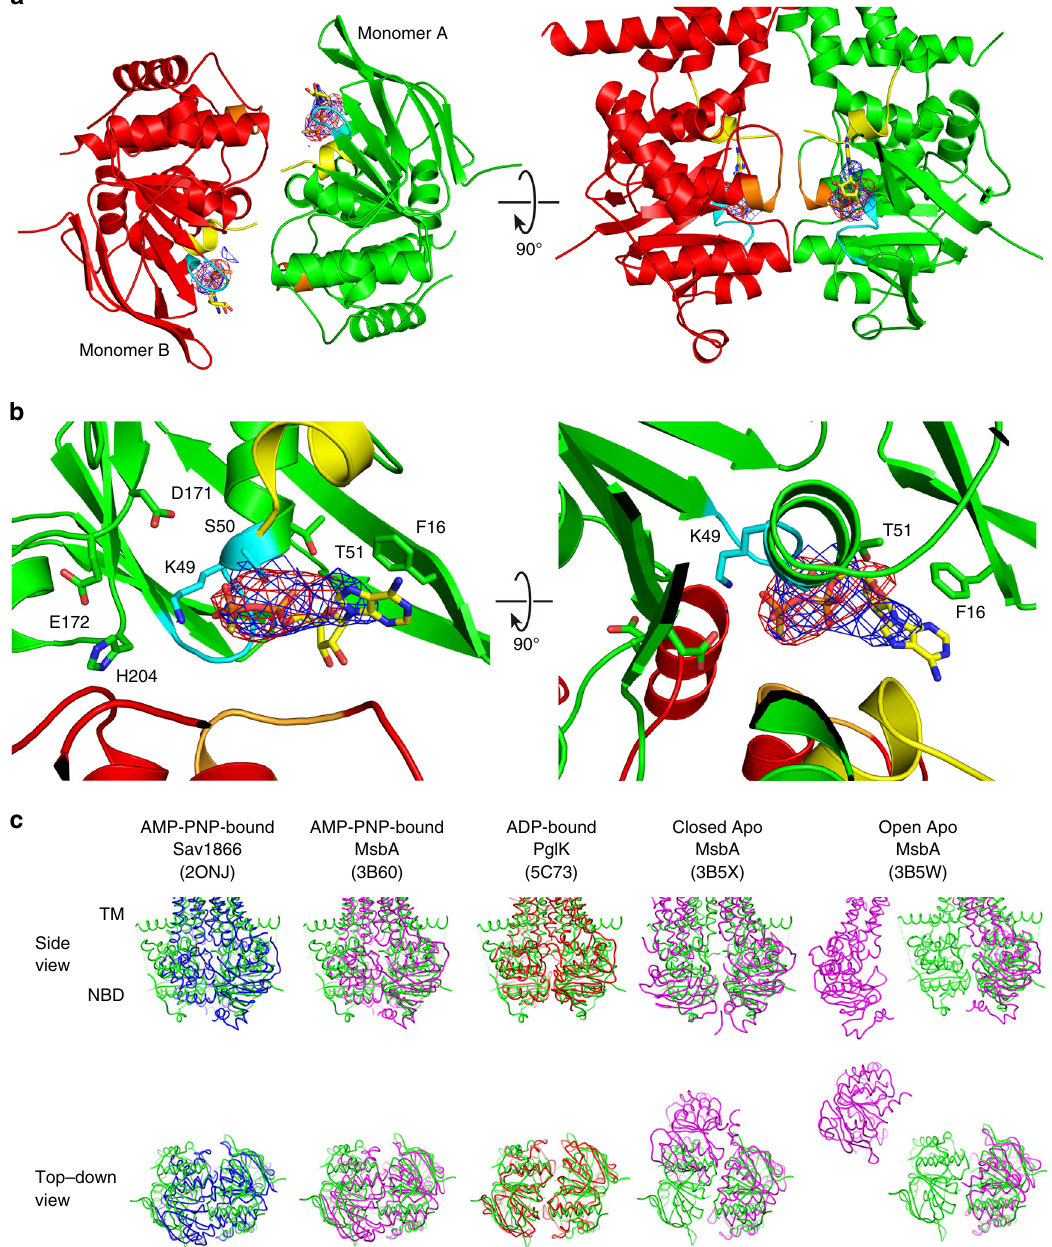
Fig. 4 Nucleotide-binding sites in MacB dimer. a NBD dimer and b close-up view of an ATP-binding site interacting with ADP β S. Each monomer in dimeric MacB is coloured in green and red, respectively. Walker A motif in cyan, and carboxy-terminal coupling helix (CH2) in yellow, LSGGQ motif in ABC signature in orange. The difference Fourier map F o – F c (without ADP β S) contoured at 2 σ ( σ is the root mean square electron density of the map) (shown in blue cage) and the anomalous difference Fourier map contoured at 4 σ (shown in red cage) for phosphor and sulphur atoms of bound ADP β S. Bound ADP β S is shown in stick representation in a and b with the positions of the C, N, O, P and S atoms indicated by yellow, blue, red, orange and gold, respectively. The positions of key residues of nucleotide-binding site in b are also shown in stick representation with the position of the C atoms indicated in green. c Structural comparison of NBDs in different nucleotide-bound states. Side view (top row) and top – down view on NBDs (bottom row). Superimposition of the right half of NBD dimers of MacB (green) vs. AMP-PNP-bound Sav1866 from S. aureus (PDB accession code: 2ONJ in blue) 60 , AMP-PNP-bound MsbA from Salmonella typhimurium (PDB accession code: 3B60 in magenta) 10 , ADP-bound PglK from C. jejuni (PDB accession code: 5C73 in red) 25 , closed apo- form MsbA from V. cholera (PDB accession code: 3B5X in magenta) 10 or open apo-form MsbA from E. coli (PDB accession code: 3B5W in magenta) 10